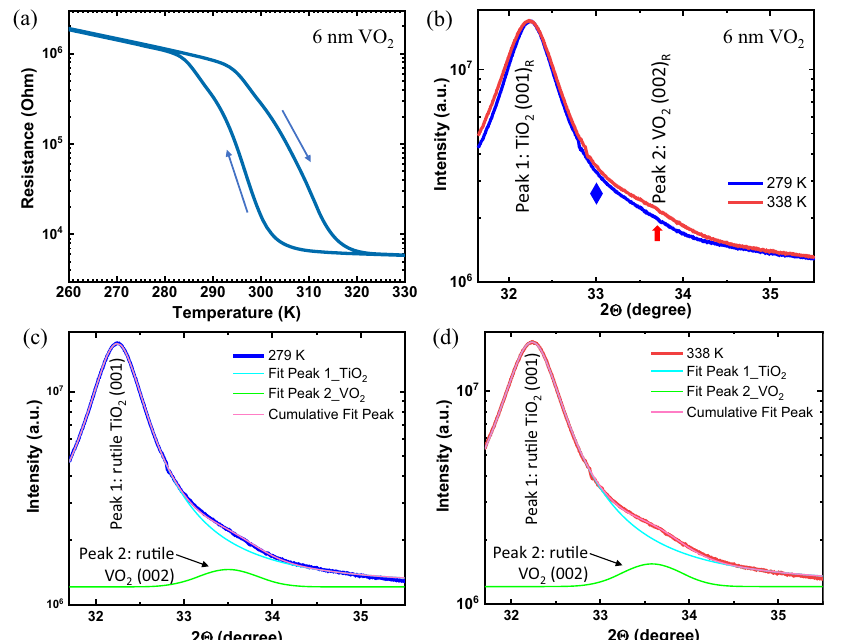
Fig. 2 Transport and structural characterization of a 6 nm thick VO 2 fi lm. a Temperature dependence of resistance of the 6 nm thick VO 2 fi lm on rutile (001) TiO 2 . b XRD patterns obtained from Synchrotron light source of the sample shown in ( a ) below (blue curve) and above (red curve) the IMT in VO 2 . c , d Fitting details of the data shown in ( b ) are given, which indicate the broad peak is rutile as displayed by a blue diamond in Fig. 2b. The synchrotron XRD data conclusively shows that the 6 nm VO 2 fi lm is in the rutile phase at 279 K (below IMT T c ) and remains in the rutile phase at 338 K (above IMT T c ). Therefore, the IMT in Fig. 2a is not accompanied by the SPT. This is direct evidence of the Mott transition from the rutile insulator phase to the rutile metal phase. We also performed XRD measurements at the Canadian Light Source on an 8 nm thick VO 2 fi lm on rutile (001) TiO 2 substrate. Thickness of the fi lm has been determined by the fi lm deposition rate. The R – T and XRD data on the 8 nm thick fi lm are shown in Fig. 3a, b respectively. The XRD data reveals a shift of the VO 2 peak upon increasing the temperature across the IMT. This shows that the top few surface layers of the fi lm undergo a SPT between the monoclinic ( M 1 ) structure and the rutile structure. The SPT is displayed as a shift from 2 θ ≈ 33.0° the monoclinic (-402) VO 2 peak, observed below IMT (277 K, blue curve), to 33.4°, designating the rutile (002) VO 2 peak above IMT (319 K, red curve). Note that the 8 nm thick fi lm exceeds the critical fi lm thickness of 7.5 nm 25 , above which the rutile lattice of the insulating phase relaxes to monoclinic ( M 1 ) lattice.